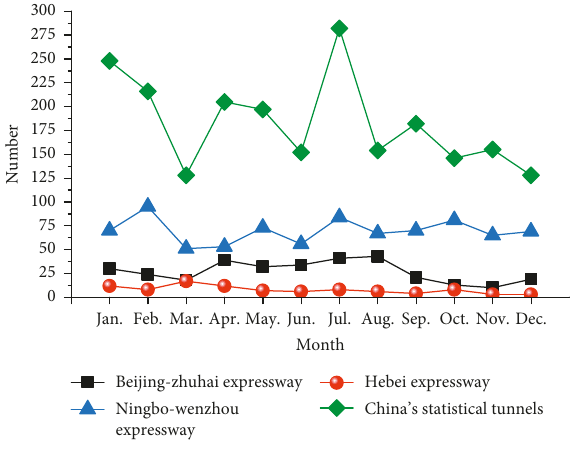
Figure 10: Monthly distributions of